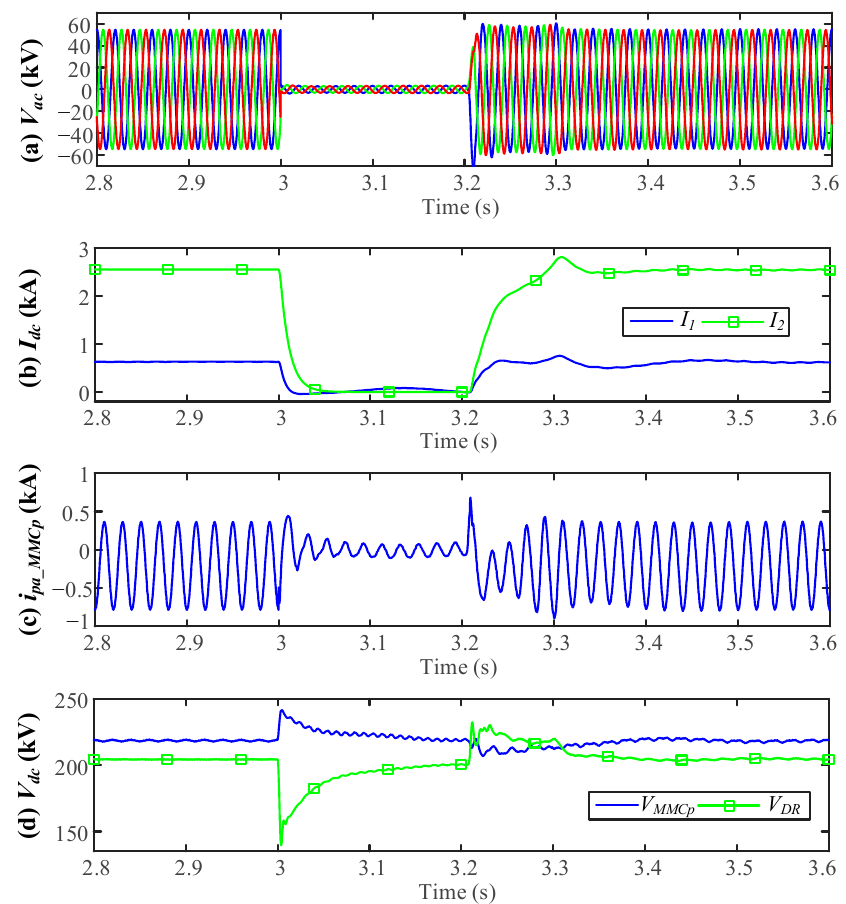
Figure 8. System performance to AC fault in P-V ac control mode: ( a ) AC voltage; ( b ) DC current; ( c ) Phase A MMC p upper arm current; ( d ) DC voltage.